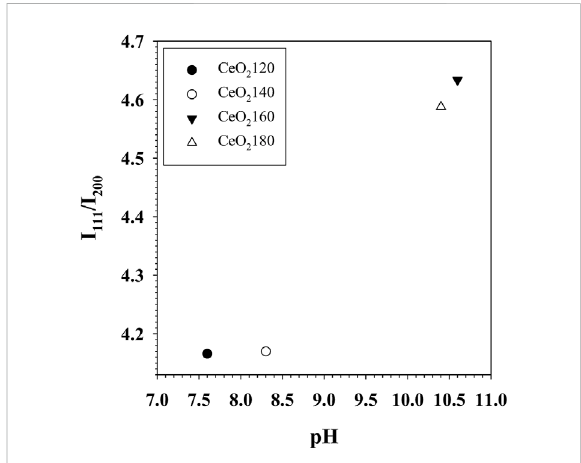
FIGURE 8 Scatter plot of the crystal phase ratio of (111)/(200) in CeO 2 X supports versus the pH of solution measured after hydrothermal aging. CeO 2 X: cerium oxide obtained at a value X for the temperature of the preparatory hydrothermal